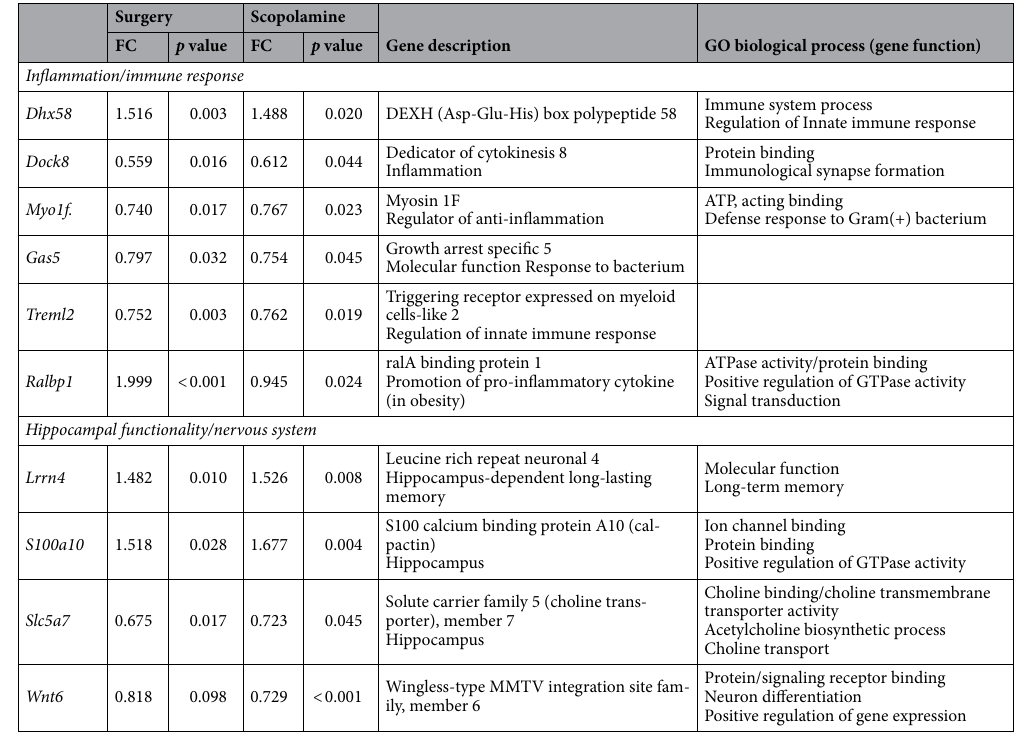
Table 1. Differentially expressed genes in surgery and scopolamine-treated mice. RNA sequencing data show several genes related to inflammation and the development of the nervous system in surgery mice and scopolamine- treated